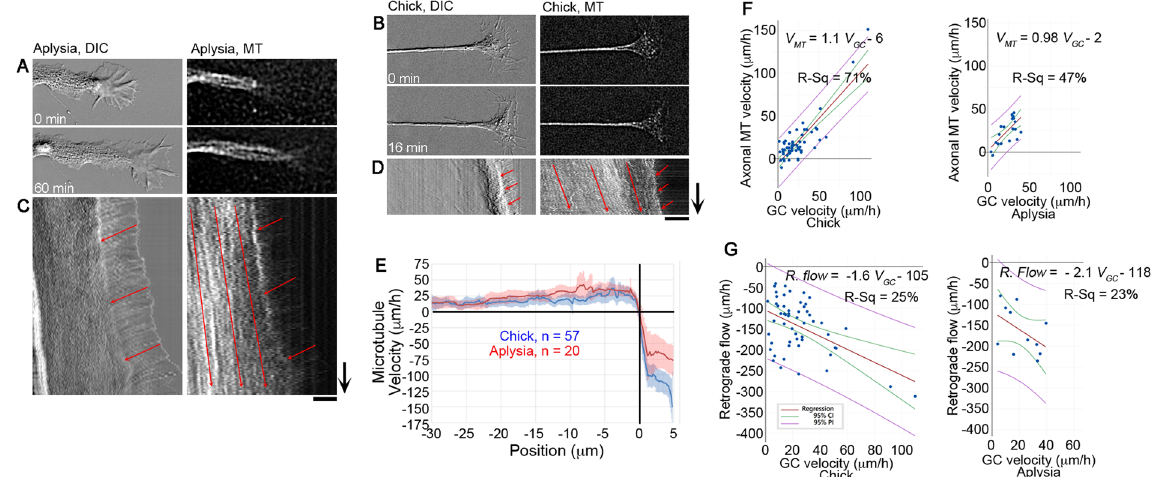
Figure 3. The pattern of MT motion is conserved between chick and Aplysia . Still images at the beginning and end of time-lapse sequences in ( A ) Aplysia and ( B ) chick neurons. Kymographs of ( C ) Aplysia and ( D ) chick neurons with red arrows indicating anterograde motion of MTs in axons and retrograde flow of phase dense material in the growth cone P domain; arrows = 10 min, bars = 10 μ m. ( E ) MT velocity as a function of distance from the T zone. ( F ) Regression analysis of axonal MT and growth cone velocity. ( G ) Regression analysis of growth cone and retrograde flow velocity.